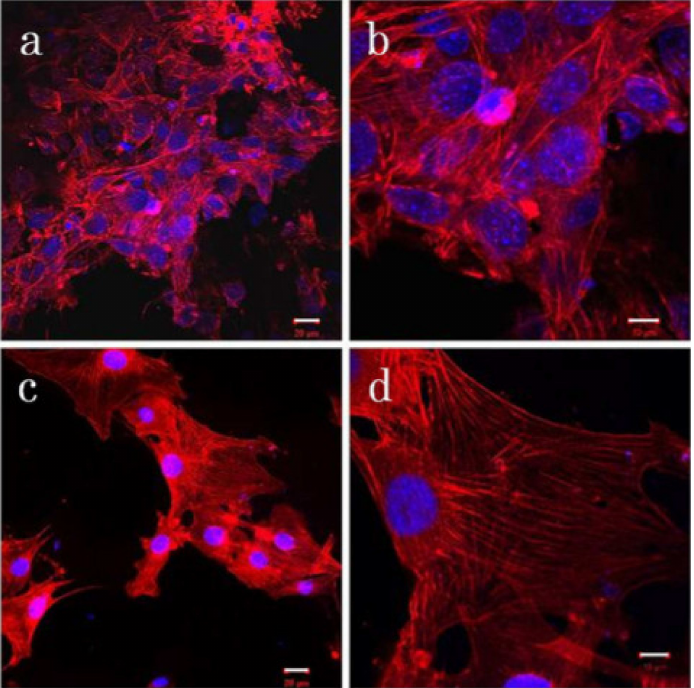
Figure 5. Fluorescence photomicrographs of cell cultures on ( a , b ) PET reinforced collagen sheets and ( c , d ) MWCNTs blocks. Reproduced from